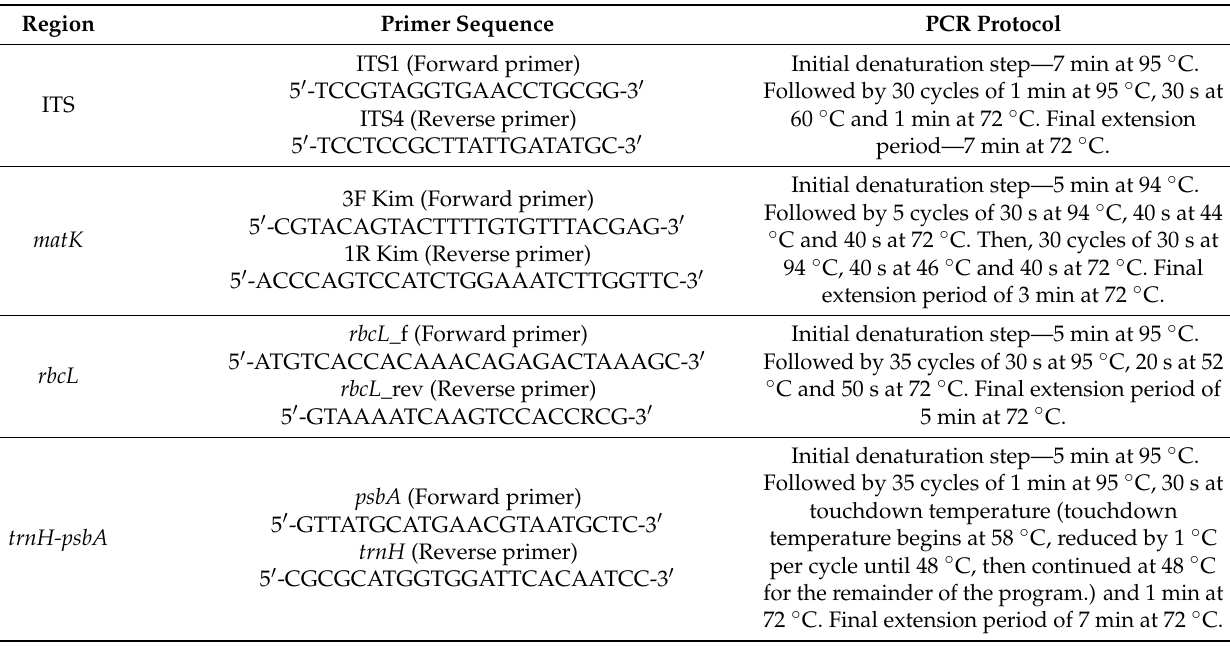
Table 4. Primers and protocols used for amplification of barcode